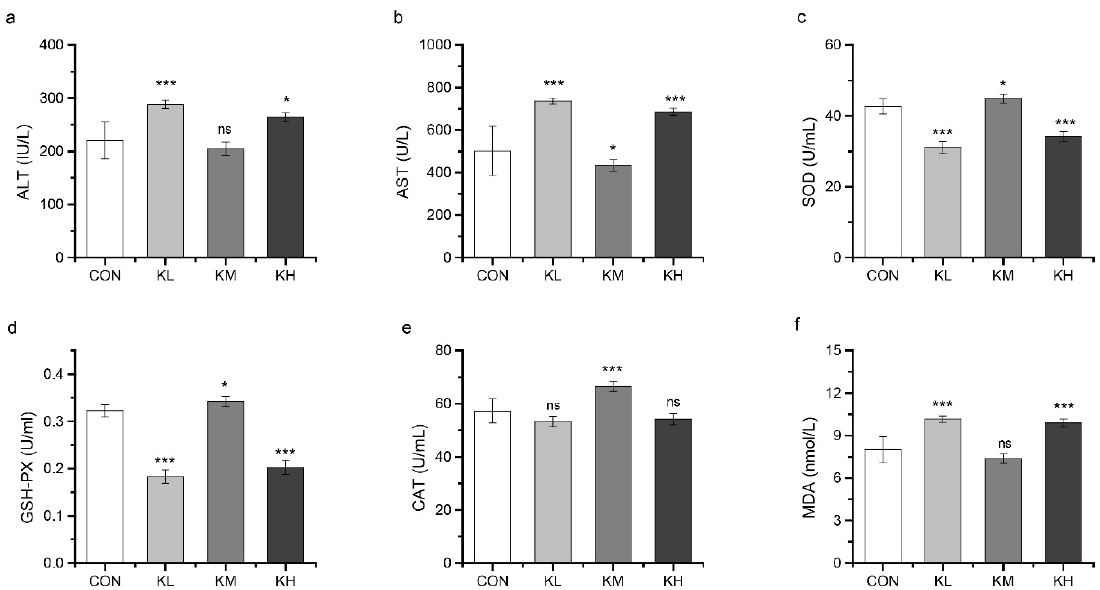
Figure 7. FKJ enhanced antioxidant capacity in vivo. The serum levels of aminotransferase (ALT) ( a ), aspartate transaminase (AST) ( b ), superoxide dismutase (SOD) ( c ), glutathione peroxidase (GSH-PX) ( d ), catalase (CAT) ( e ), and malonaldehyde (MDA) ( f ). The control group was expressed as CON, and FKJ supplemented with low-dose, medium-dose, and high-dose were expressed as KL, KM, and KH. * p < 0.05; *** p < 0.001; and ns p > 0.05. Compared with CON group.